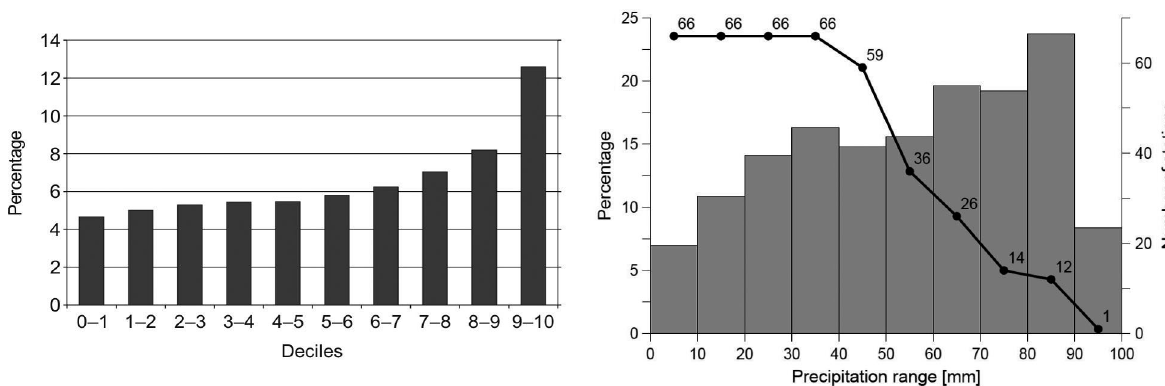
Fig. 5. Percentage of daily MCP sums in total precipitation in the area of Poland: according to deciles of daily totals distribu- tion (left graph) and to ranges of daily totals of 0–10, 10–20, 20–30 mm etc. (right-closed intervals; right graph). In the right graph, the number of meteorological stations which recorded MCP is indicated (black line with